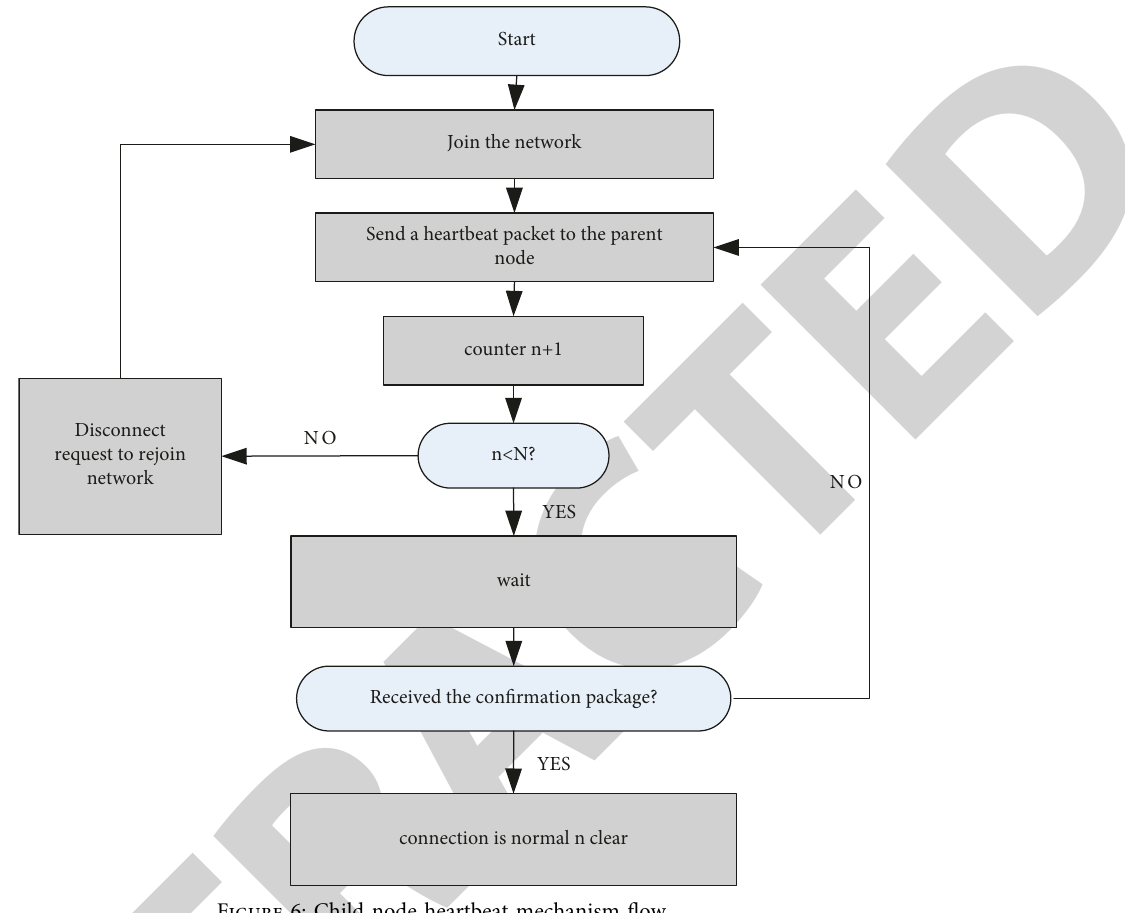
Figure 6: Child node heartbeat mechanism